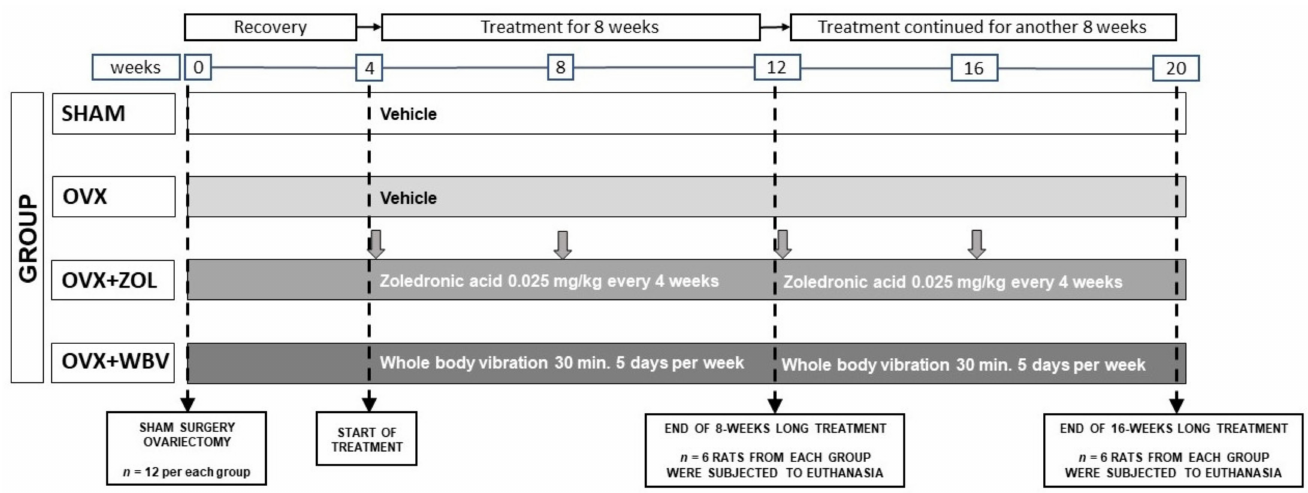
Figure 1. Scheme of the experimental design. Four weeks after the ovariectomy, rats from the OVX + WBV group were subjected to whole body vibration treatment (30 min., 5 days per week) while rats from the OVX + ZOL group were injected with Zoledronic acid (i.m. 0.025 mg/kg every 4 weeks, vertical gray arrows show the time of injections). Rats from the SHAM, OVX and OVX + WBV groups were injected with the vehicle (0.9% NaCl) at the same volume. After the 8th and the 16th week of treatment, six animals from each group were